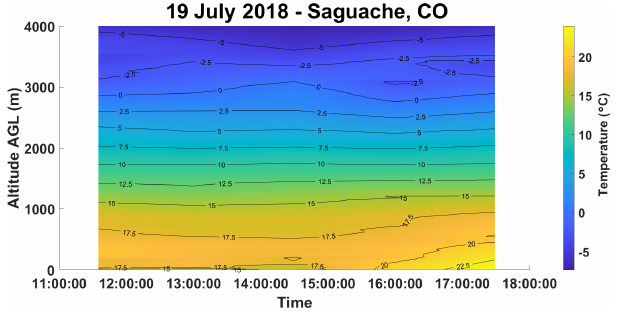
Figure 7. Time series of air temperature from five